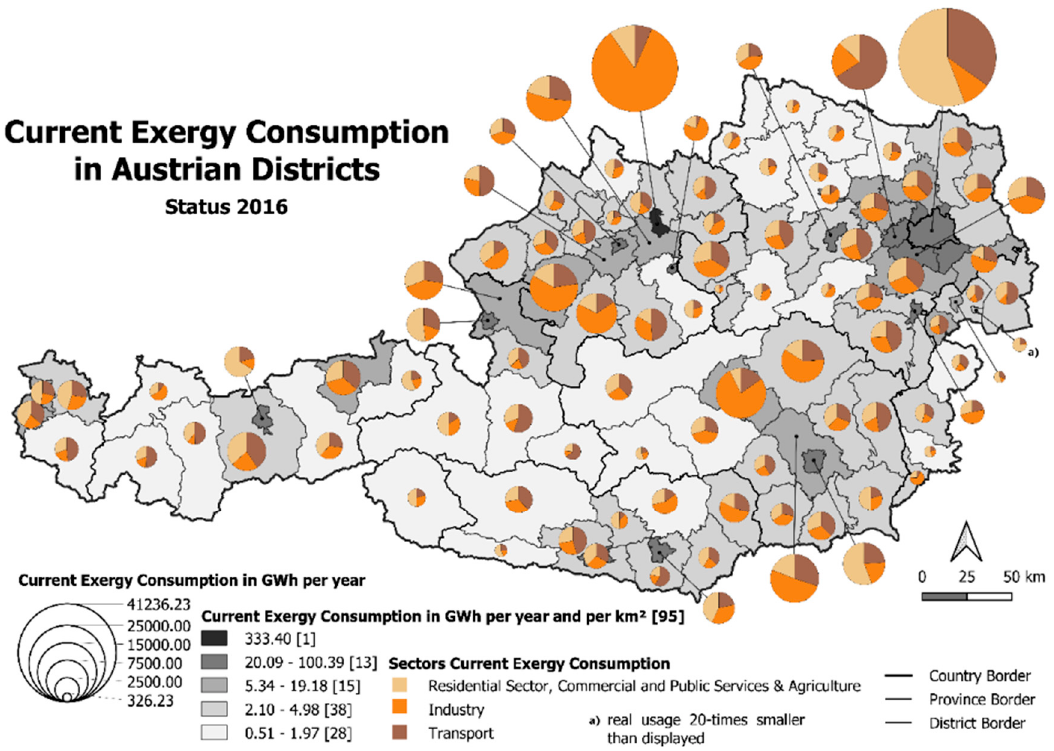
Figure 7. Current exergy consumption in Austrian districts. The absolute and relative consumption is represented by the size of the pie charts and by the gray scales, respectively. The maximum consumption can be found in industrial and urban areas (map source: Statistics Austria - data.statistik.gv.at).